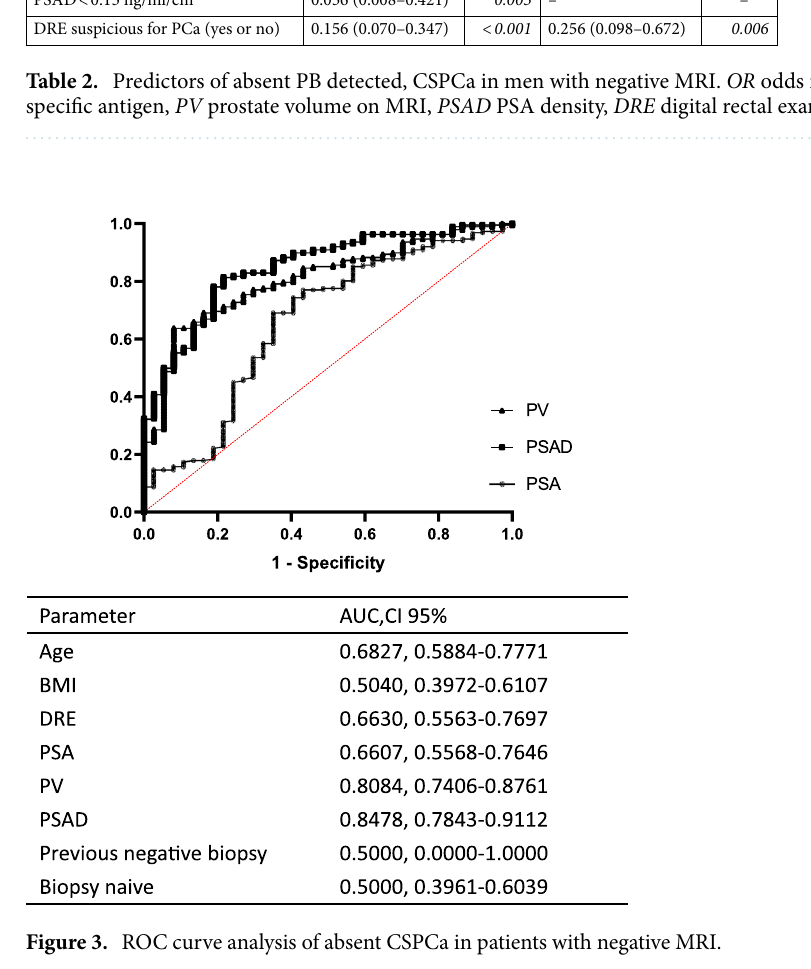
Figure 3. ROC curve analysis of absent CSPCa in patients with negative